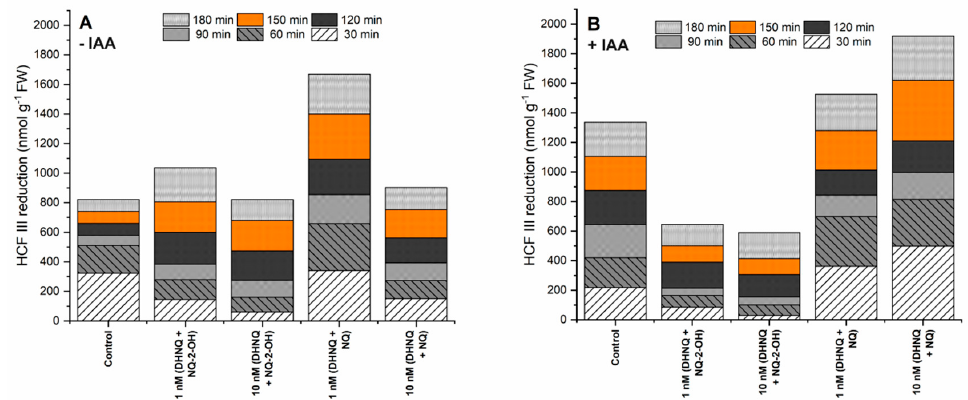
Figure 5. The effect of DHNQ combined with NQ-2-OH or NQ on the redox activity measured as the HCF III reduction in the maize coleoptile segments that had been incubated ( A ) without and ( B ) with IAA. The presented data is the mean of six independent experiments. Bars indicate the means ± SEs. The addition of only auxin to the incubation medium caused an increase in the redox activity by ca. 60% (1336.2 ± 66.8 nmol g − 1 FW) compared to the control (Figure 5B). The incubation of the maize coleoptile segments with the combination of DHNQ and NQ at concentrations of 1 and 10 nM in the presence of IAA caused a strong increase of the hexacyanoferrate III reduction (Figure 5B). However, the administration of auxin to the combination of naphthazarin and lawsone at both of the concentrations that were tested had the reverse effect on the redox activity in the maize coleoptile segments. In this case, the reduction of HCF III was diminished. 2.4. Effects of Naphthazarin (DHNQ) Combined with Lawsone (NQ-2-OH) or 1,4-Naphthoquinone (NQ) on Lipid Peroxidation and Cell Viability The effect of naphthazarin combined with lawsone or 1,4-naphthoquinone on lipid peroxidation was also studied. The results are presented in Figure 6. In the control conditions, the MDA